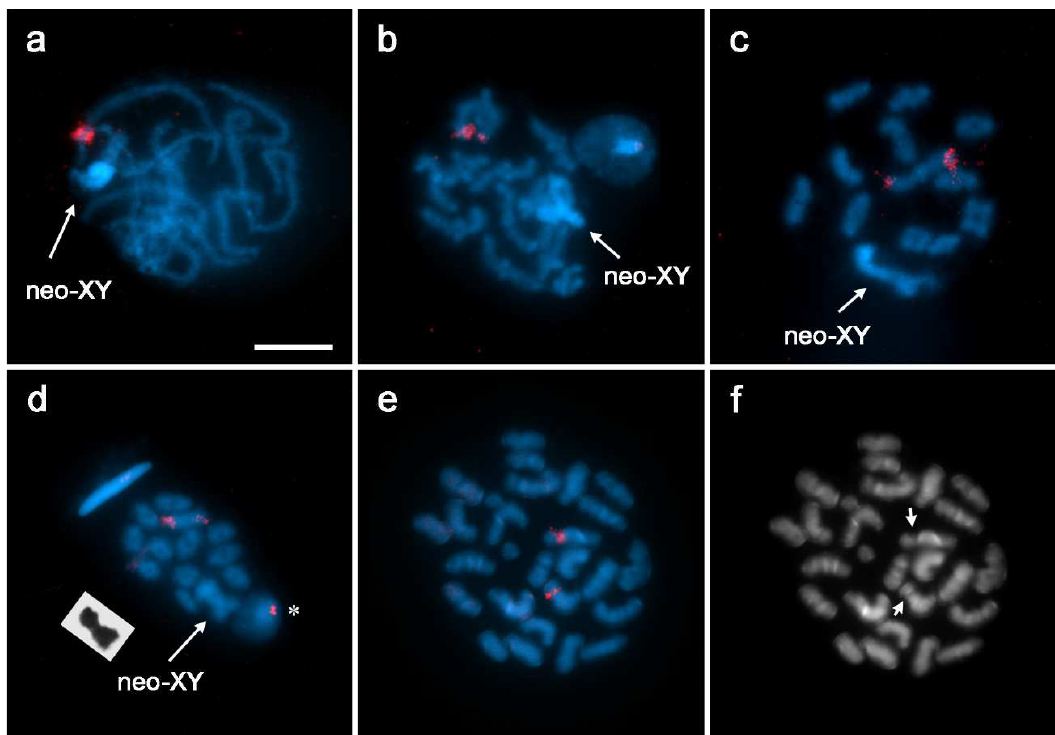
Figure 1. Localization of rDNA in Rhionaeschna bonariensis (n = 12 + neo-XY) ( a – d ) and Aeshna cyanea (2n = 27) ( e , f ) by FISH with 18S and 28S rDNA probes, respectively (red signals). ( a ) Pachytene; ( b ) early diakinesis; ( c ) diakinesis; ( d ) prometaphase I, inset: Giemsa-stained neo-XY bivalent from another cell, *: early spermatid with rDNA signal; ( e , f ) the same spermatogonial prometaphase: ( e ) composite FISH image; ( f ) DAPI staining; arrows point to secondary constrictions. Bar = 10 µ m. Rhionaeschna planaltica (2n = 16, n = 7 + neo-XY) has a reduced diploid chromosome